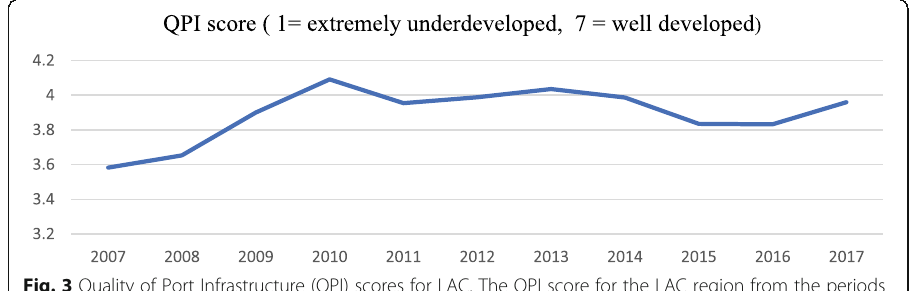
Fig. 3 Quality of Port Infrastructure (QPI) scores for LAC. The QPI score for the LAC region from the